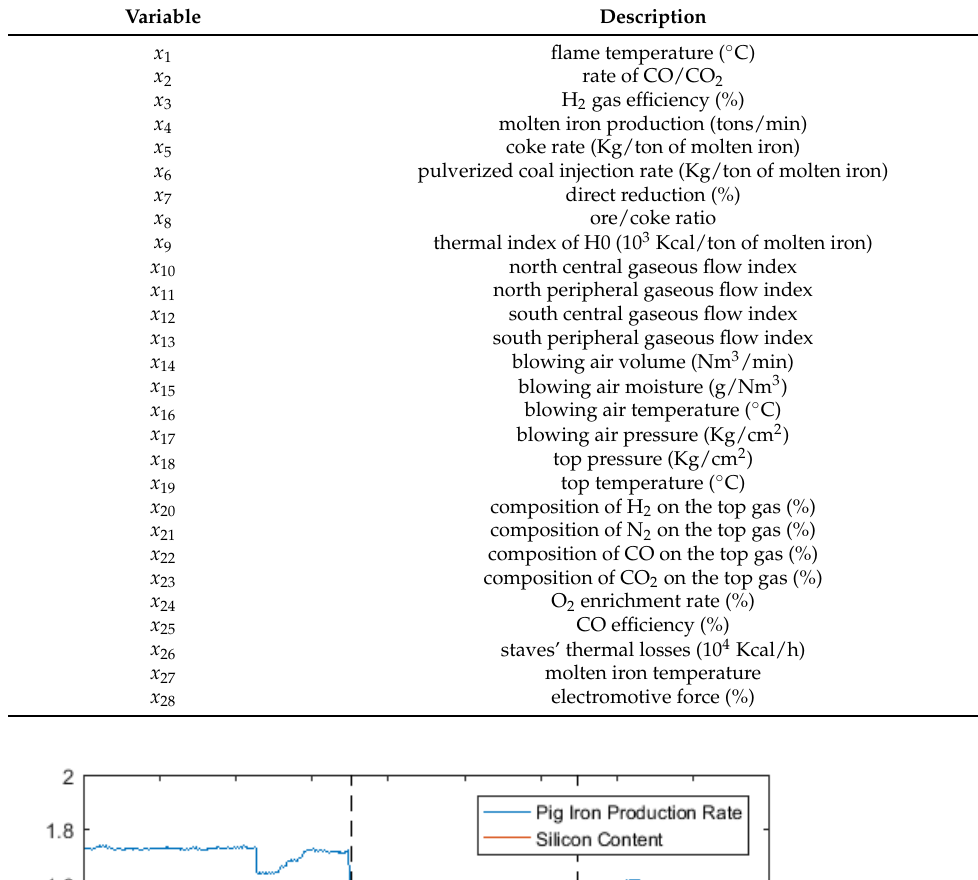
Table 1. Input variables that may influence the silicon content.